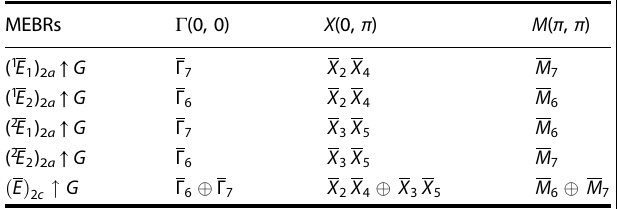
Table 1. The MEBRs induced by maximal symmetry Wyckoff positions in P 4 0 / n 0 m 0 m 22,52 .